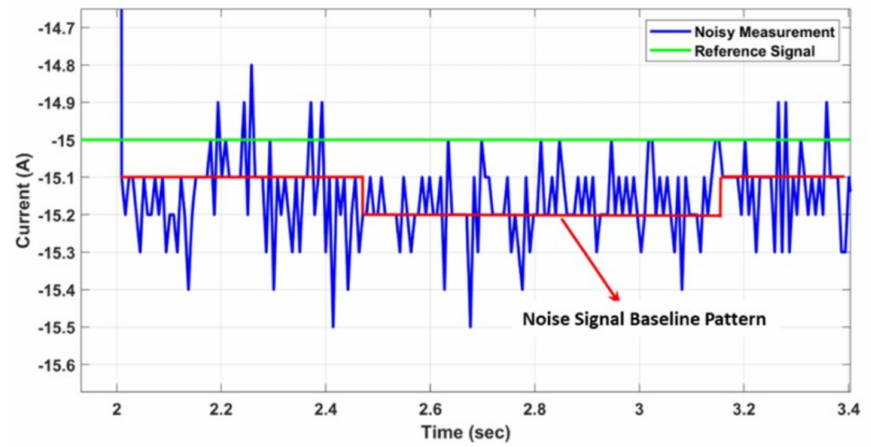
Figure 21. Measurement of noisy signal with the variable